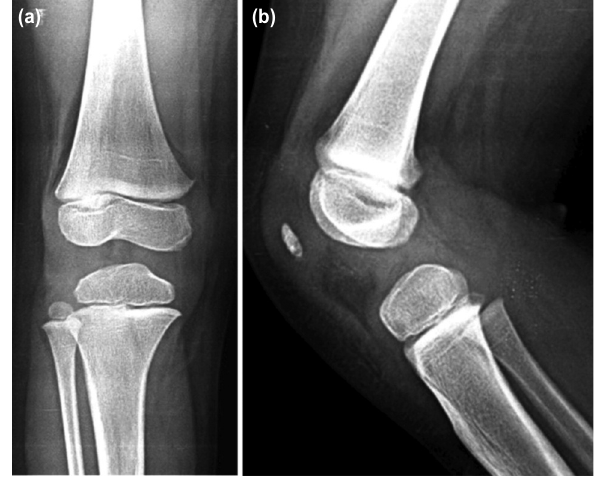
(a) Pre-operative anteroposterior and (b) lateral Fig. 1: radiographs of the right knee before femoral derotational osteotomy surgery.